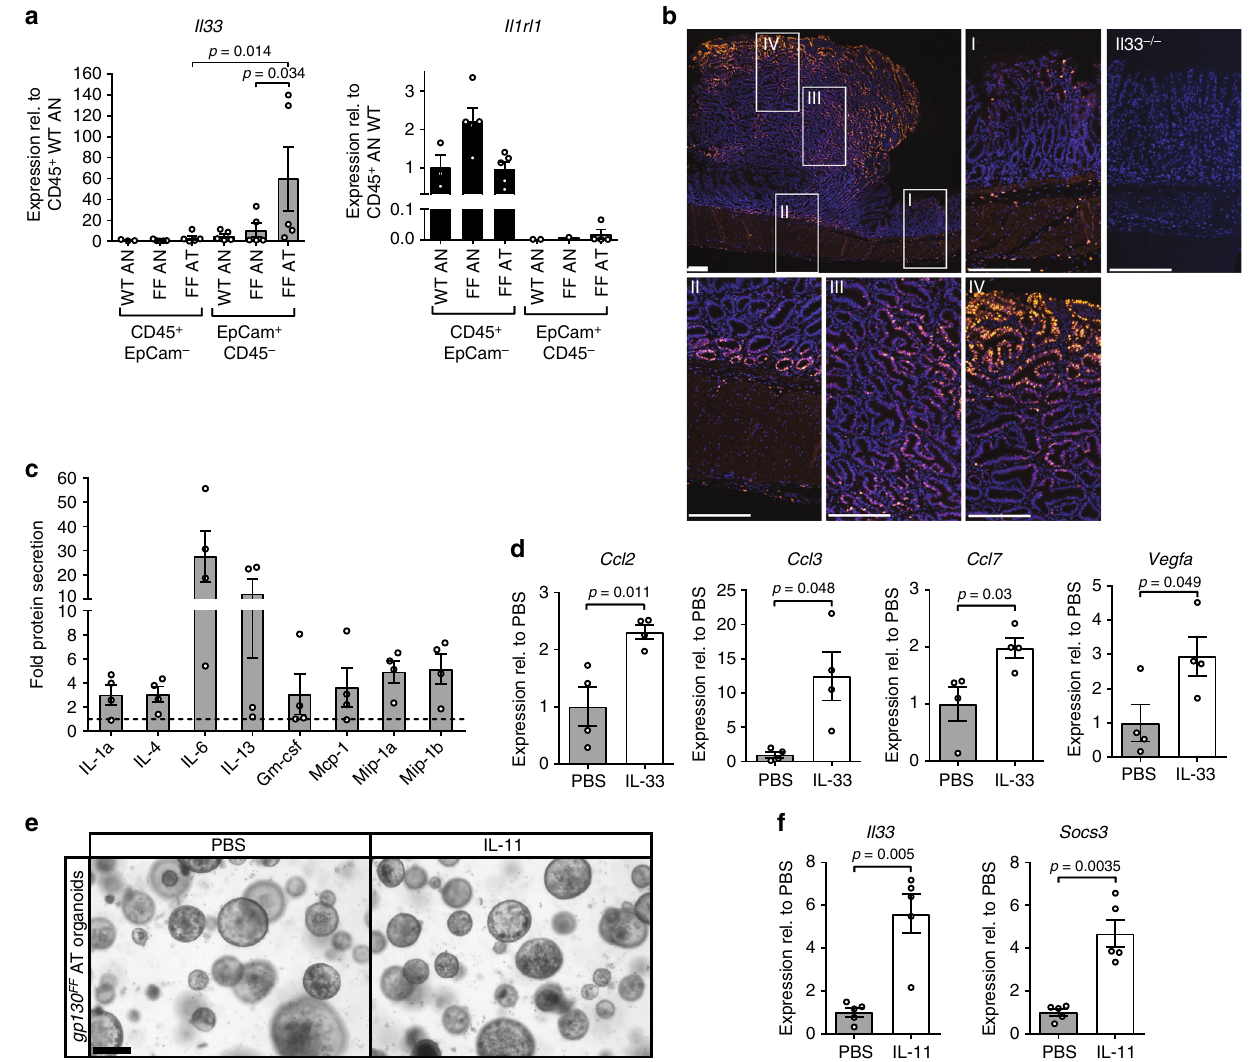
Fig. 6 IL-33 expression in gastric tumors of gp130 FF mice and mast cell activation analysis. a qPCR expression analysis of Il33 and full-length St2 ( Il1rl1 ) genes associated with hematopoietic (CD45 + ; EpCam − ) and epithelial (EpCam + ; CD45 − ) cells puri fi ed from unaffected antrum (AN) or antrum tumors (AT) from wild-type and gp130 FF (FF) mice. Data are normalized to Gapdh and plotted as relative expression to CD45 + ; EpCAM − WT AN expression. n = 5 mice. Il1rl1 expression in EpCam + ; CD45 − cells was for several samples below detection limit. Data was pooled from two independent experiments. For IL33 data, one-way ANOVA was performed with F (DFn, Dfd) = 2.871(5, 22); b Immuno fl uorescence staining for IL-33 in stomachs of tumor-bearing gp130 FF mice with insets referring to unaffected antrum (I), submucosal-tumor junction (II), tumor core (III), and tumor edge (IV). Stomachs from Il33 − / − mice were used for speci fi city controls. Scale bars = 200 µ m. c Multiplex cytokine analysis of supernatant of FACS-puri fi ed tumor-associated mast cells stimulated with IL-33 (30 ng/ml) for 3 h. Data are shown only for factors with > 3 fold increase relative to unstimulated control cultures. n = 4 from four independent experiments. d qPCR gene expression analysis in FACS-puri fi ed tumor-associated mast cells stimulated with IL-33 (30 ng/ml) for 3 h or vehicle. n = 4 from four independent experiments. Ccl2 : t -test t (df) = 3.61 (6); Ccl3 : t -test t (df) = 3.2 (3.09); Ccl7 : t -test t (df) = 2.84 (6); Vegfa : t -test t (df) = 2.45 (6). e Representative images of organoids derived from antral tumors (AT) of gp130 FF mice stimulated either with PBS or IL-11 (100 ng/ml for 2 days). Scale bar = 200 µ m. f Il33 gene expression analysis of gp130 FF tumor-derived epithelial organoids either stimulated with IL-11 (100 ng/ml) or with PBS for 4 h. For comparison expression of Stat3-target gene, Socs3 , was also analyzed. n = 5 from two independent experiments. Stat3 : t -test t (df) = 4.96 (4.42); Socs3 : t -test t (df) = 5.6 (4.48). Data are represented as mean ± SEM, with p values p < 0.05 considered being signi fi cant. Source data are provided as a Source Data fi le. See also related Supplementary Fig. Fig. 6e). At the time point of tumor analysis 8% of the gastric submucosal mast cells stained positive for St2 expression and therefore represent the transplanted BMMC mast cells, which homed to the gastric tumor site and compete with the endogenous ST2 − / − mast cell compartment (Supplementary Fig. 6f). These observations further support a mechanism by which IL- 33 promotes gastric tumorigenesis through mast cell activation rather than by promoting ILC2 or Treg accumulation.